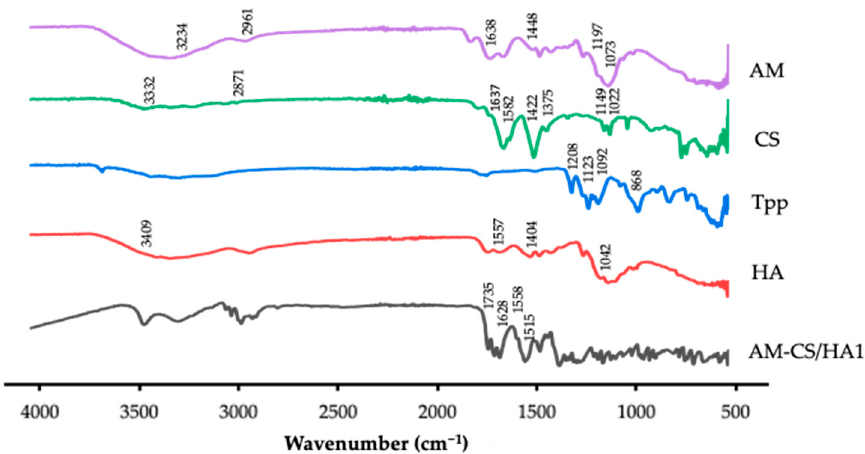
Figure 2. FTIR spectrum of raw material and